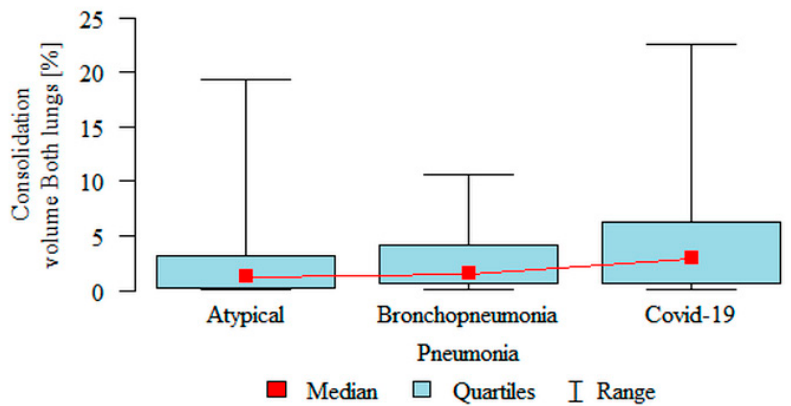
Figure 5. Comparison of the volume of consolidation as a percentage of the volume of both lungs, in three subgroups of pneumonia.